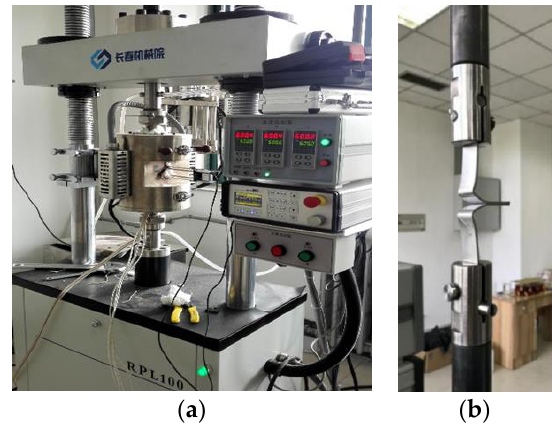
Figure 3. ( a ) Testing machine and ( b ) the clamping of the T-type brazed joint.